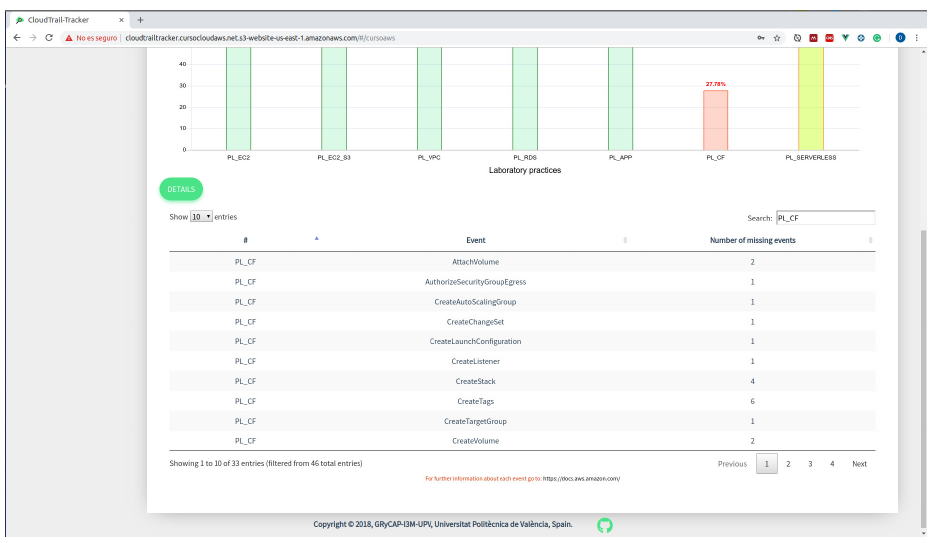
Figure 5. Missing actions for each hands-on lab for a specific student.